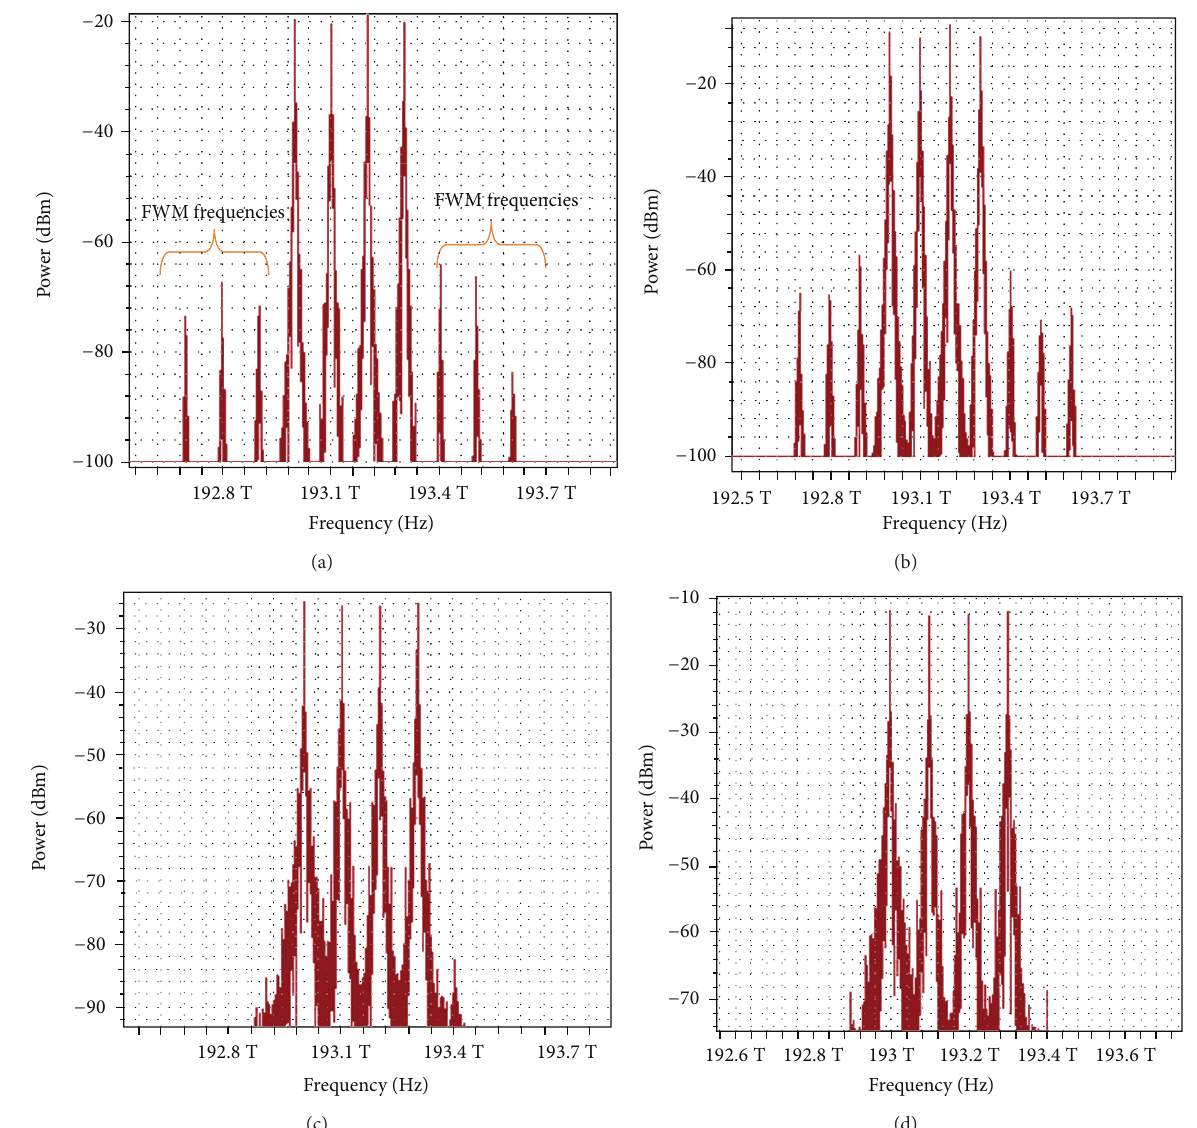
Figure2: Opticalspectrumcomparisonafter70 kmSMF(a)withoutpolarizationtechniqueatinputpowerof2 dBm,(b)withoutpolarization technique at input power of 14 dBm, (c) with polarization technique at input power of 2 dBm, and (d) with polarization technique at input power